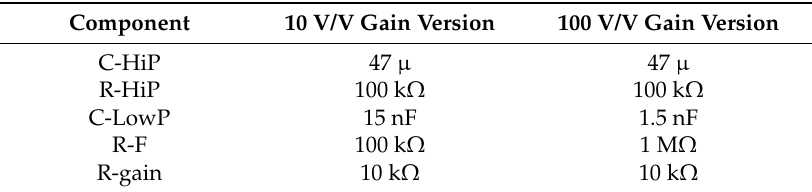
Figure 3. Active band-pass filter gain cell, see Table 1 for components’ values. Table 1. Summary of components’ values for the gain cells.